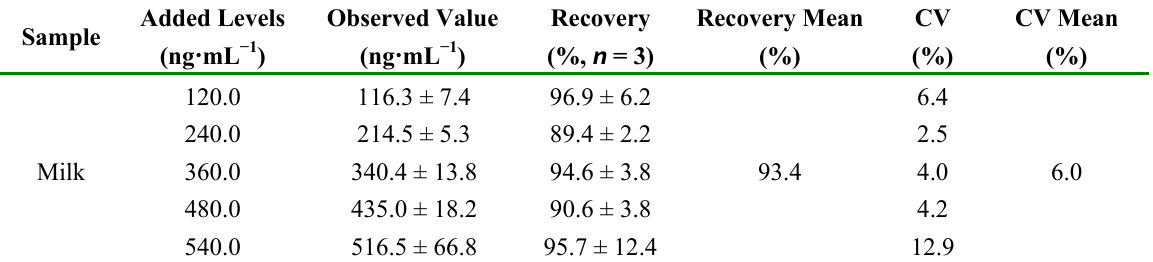
Table 3. Recovery of melamine from the spiked samples by icELISA.